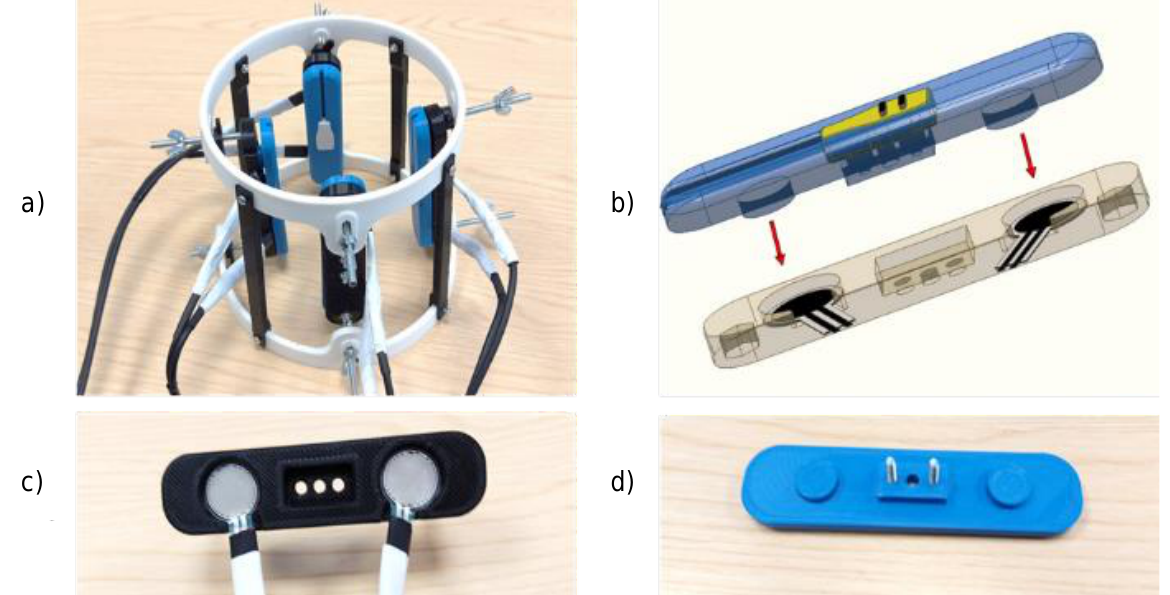
Figure 1 : (a): The 3D-printed compression rig; (b): A CAD representation of the compression bar showing the inbuilt FSR depressors; (c): The top half of a compression bar, showing the FSR sensors inside; (d): The bottom half of a compression bar, showing the FSR